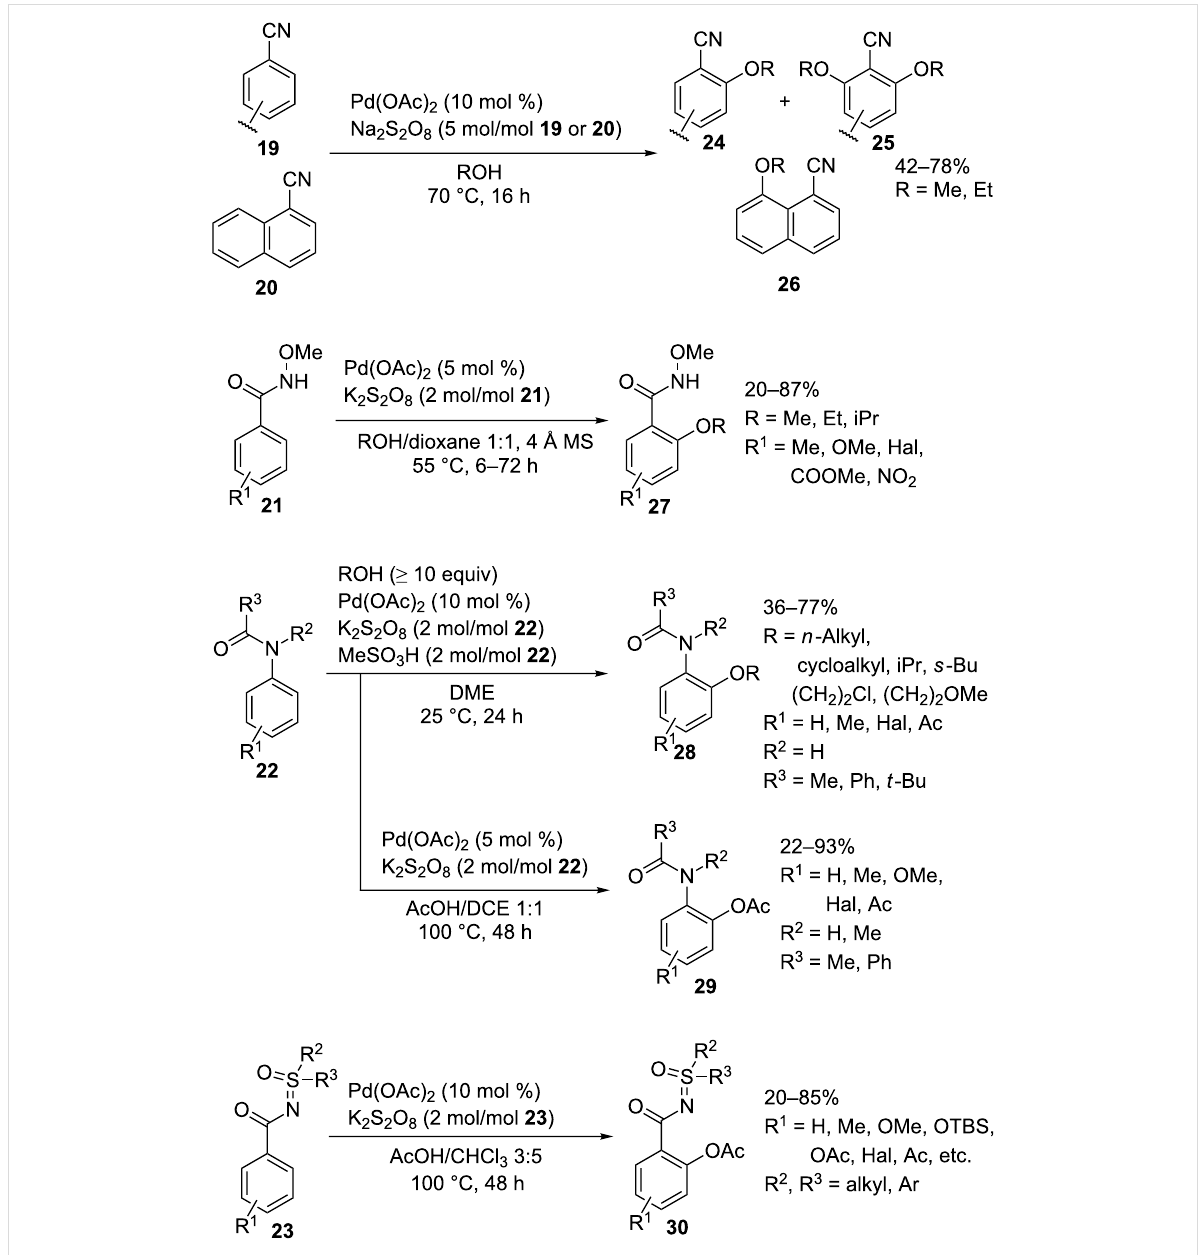
Scheme 6: Pd(OAc) 2 /persulfate oxidative system in the ortho -alkoxylation and acetoxylation of arenes with nitrile, amide, and sulfoximine directing groups.